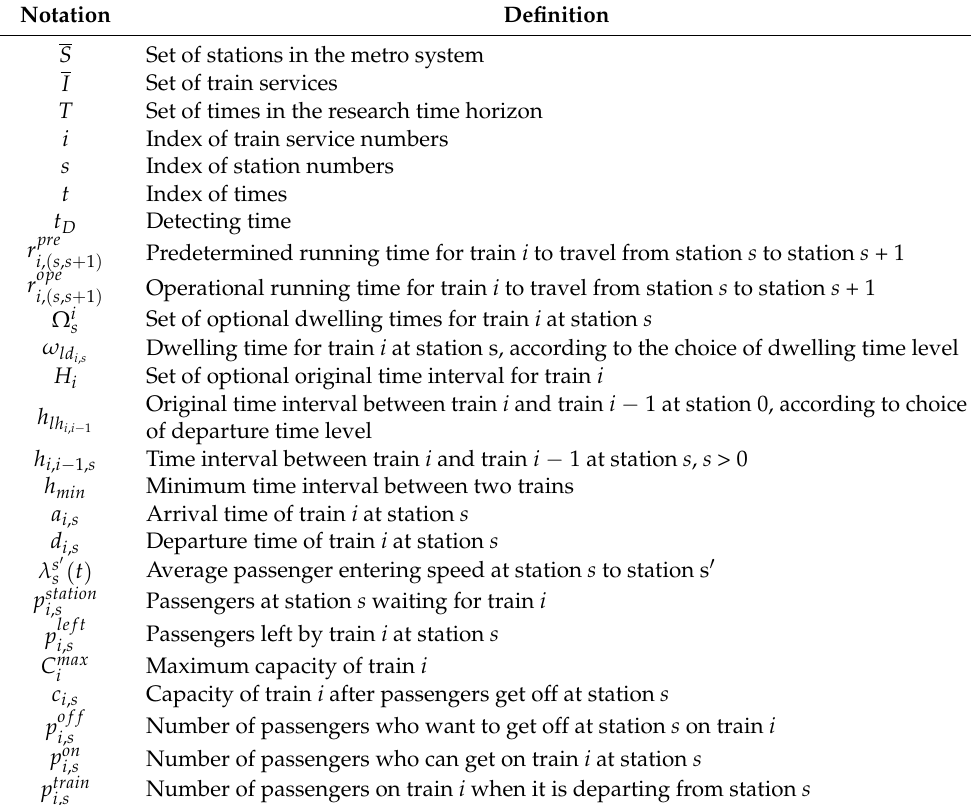
Table 3. Notations and Parameters in this